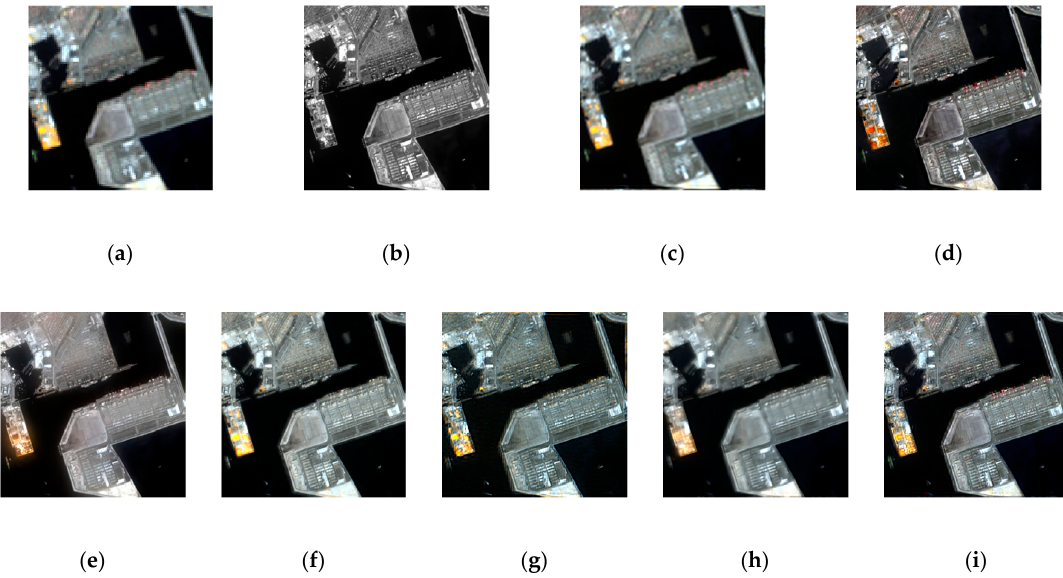
Figure 7. Experimental results obtained by each method for Hyperion dataset. ( a ) Real HS image; ( b ) Real PAN image; ( c ) Interpolated HS image; ( d ) GS; ( e ) GFPCA; ( f ) CNMF; ( g ) HySure; ( h ) Bayesian; ( i ) HFWT.